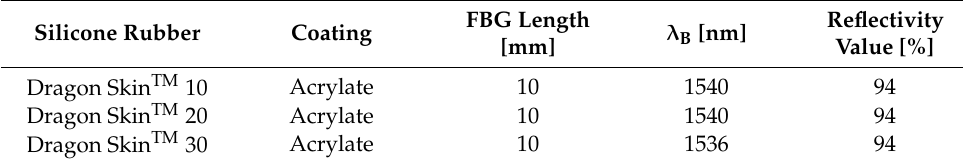
Table 2. Technical specifications of FBGs used.